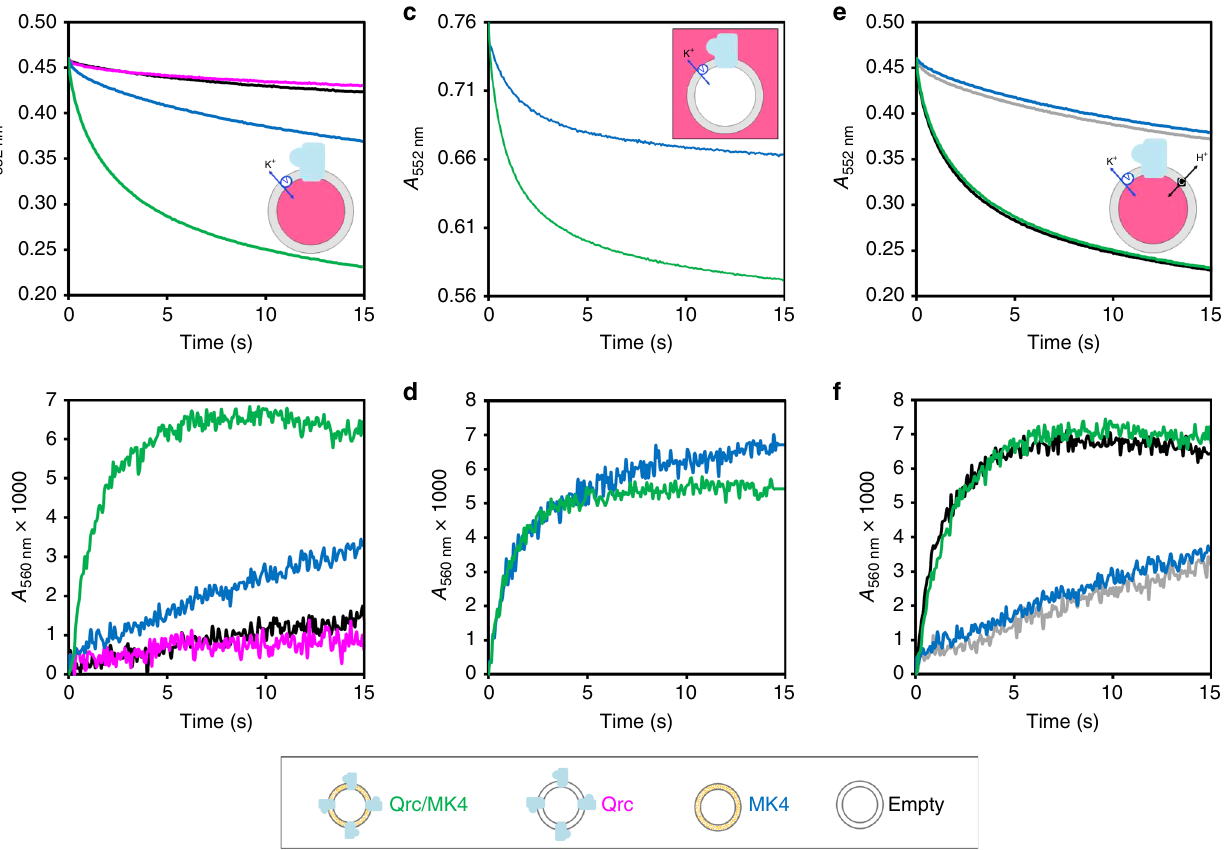
Fig. 3 Electron and proton transfer. a Absorbance changes at 552 nm and b at 560 nm, after mixing reduced TpI c 3 with valinomycin permeabilised liposomes prepared with phenol red in the inner solution. Empty liposomes (black), Qrc proteoliposomes (magenta), MK4-liposomes (blue), and Qrc/MK4 proteoliposomes (green). c Absorbance changes at 552 nm and d at 560 nm, after mixing reduced TpI c 3 with valinomycin permeabilised liposomes and phenol red in the outer solution, MK4-liposomes (blue) and Qrc/MK4 proteoliposomes (green). e Absorbance changes at 552 nm and f at 560 nm, after mixing reduced TpI c 3 with valinomycin permeabilised liposomes prepared with phenol red in the inner solution in the presence of CCCP, MK4-liposomes (blue), Qrc/MK4 proteoliposomes (green), CCCP permeabilised MK4-liposomes (grey), and CCCP permeabilised Qrc/MK4 proteoliposomes (black). All traces correspond to the average of at least seven experiments performed with at least two distinct liposome